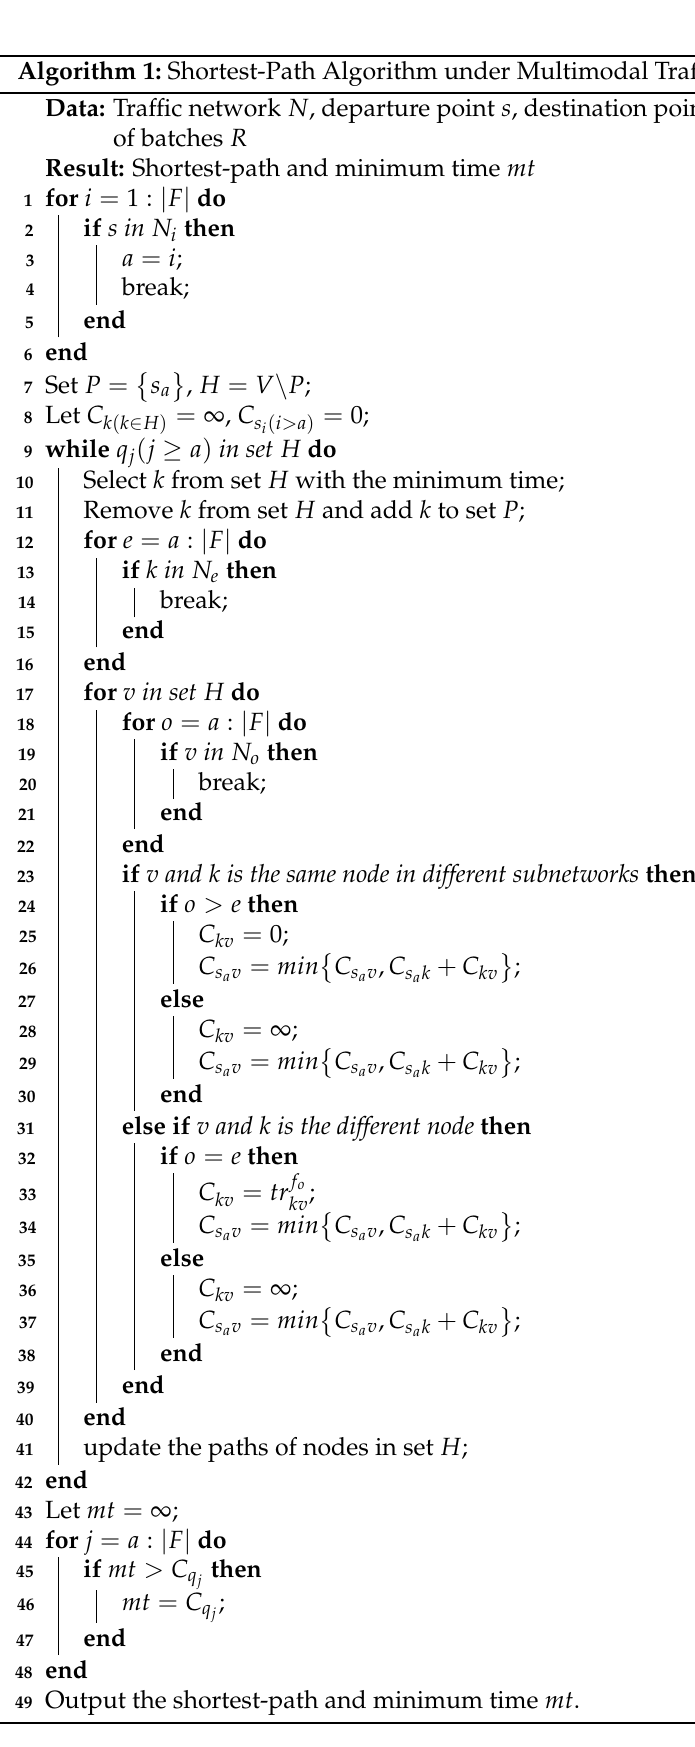
Algorithm 1: Shortest-Path Algorithm under Multimodal Traffic